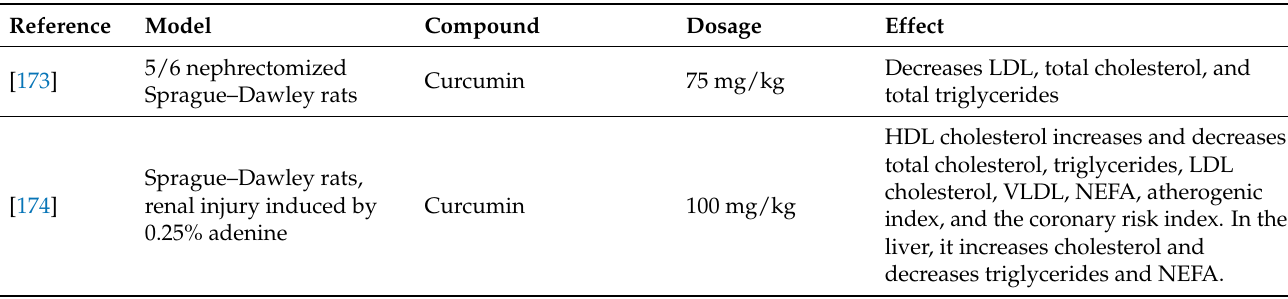
Table 4. Curcuminoids’ effects on CKD